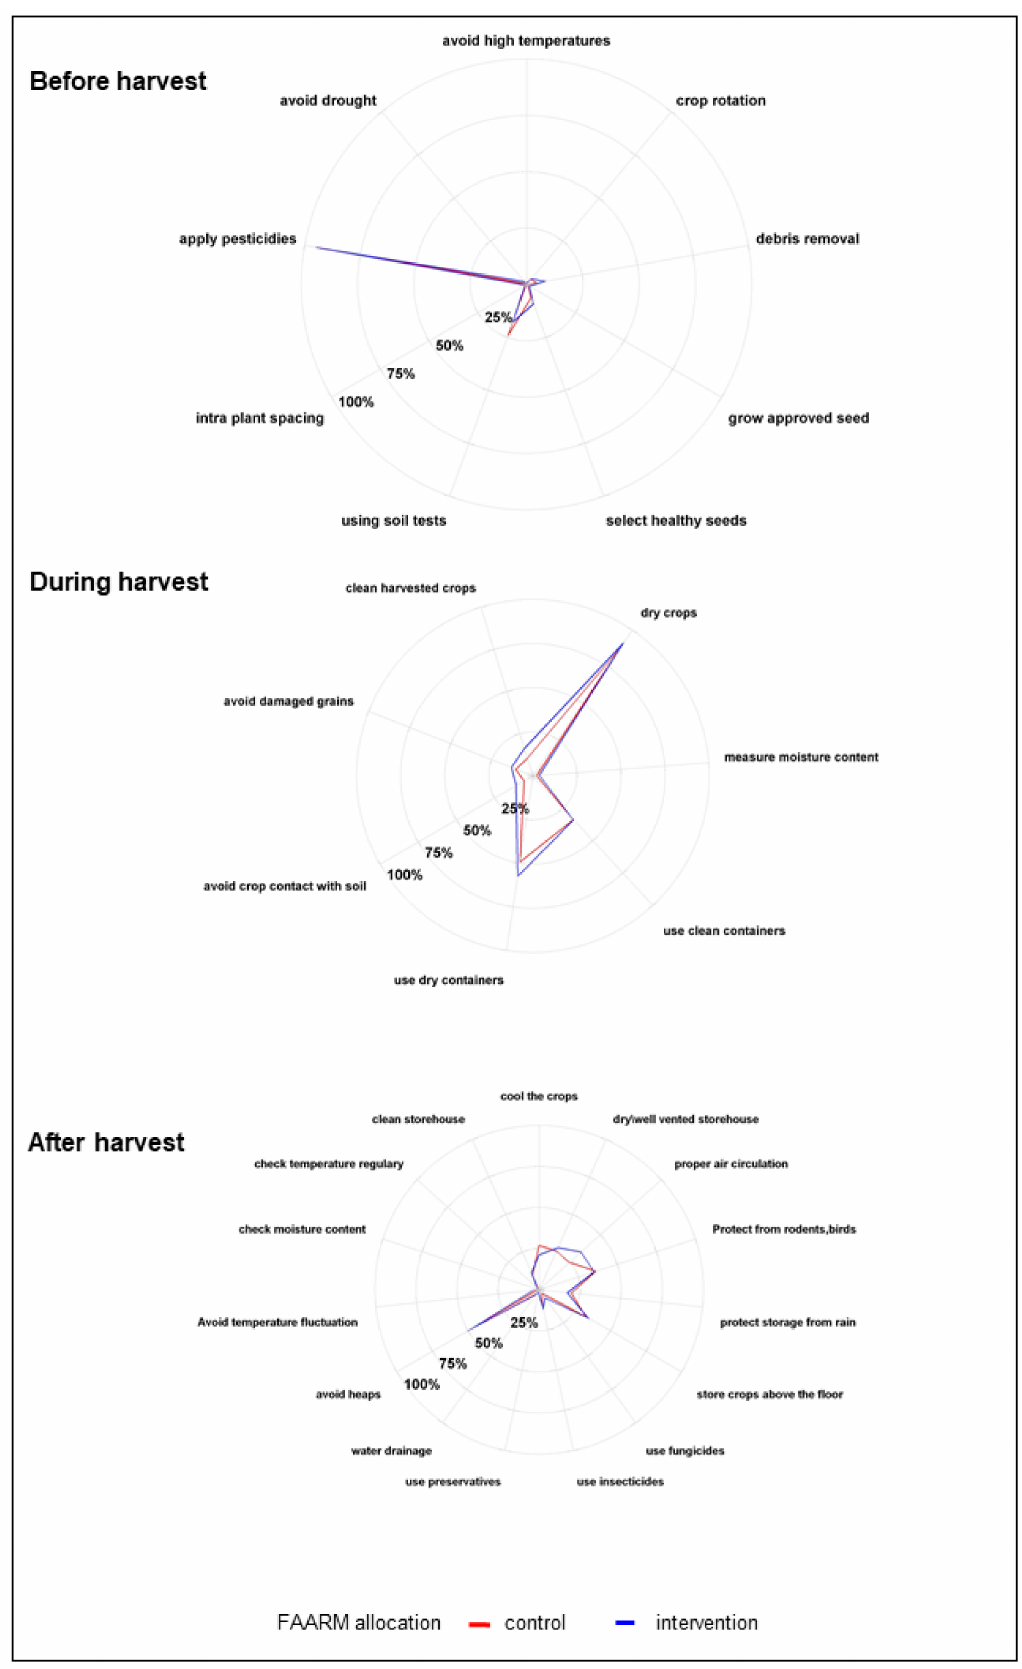
Figure 4. Prevention practices for mold contamination ( n =